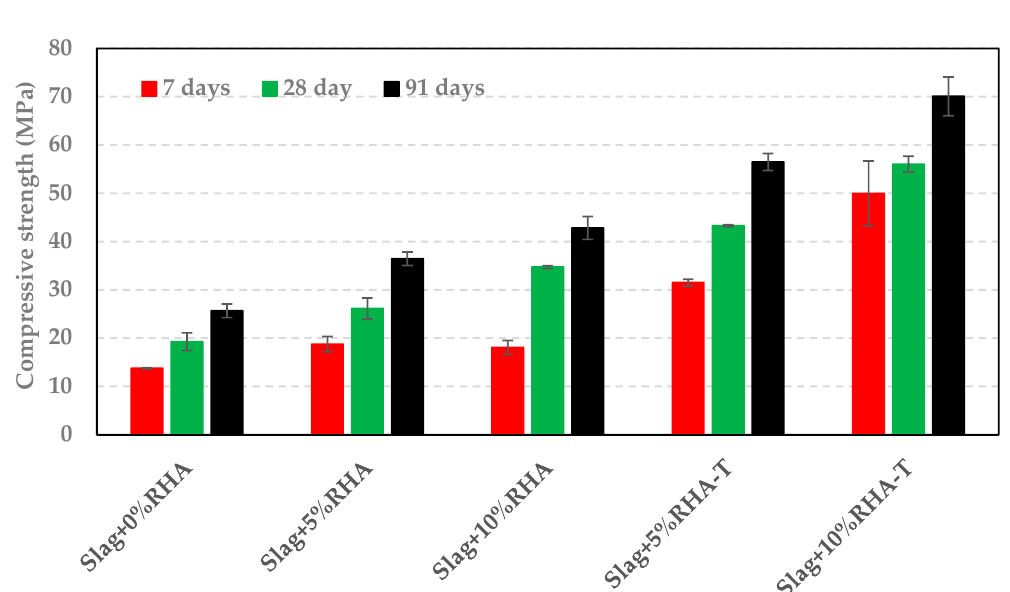
Figure 8. Compressive strength of samples containing RHA.